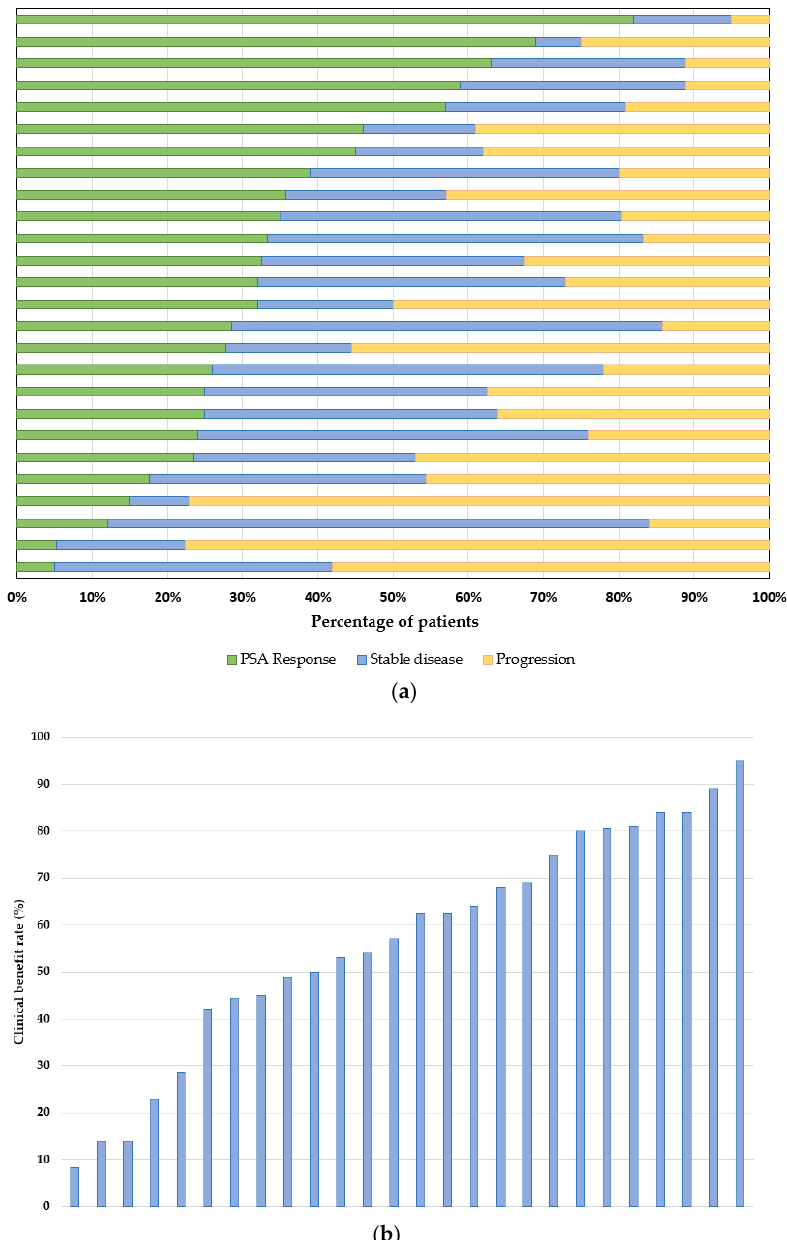
Figure 5. ( a ) Biochemical response assessment based on prostate specific antigen (PSA) across 26 informative studies. PSA response was defined as a  50% treatment-related PSA decrease compared with baseline. ( b ) Clinical benefit rate (%) across 26 informative